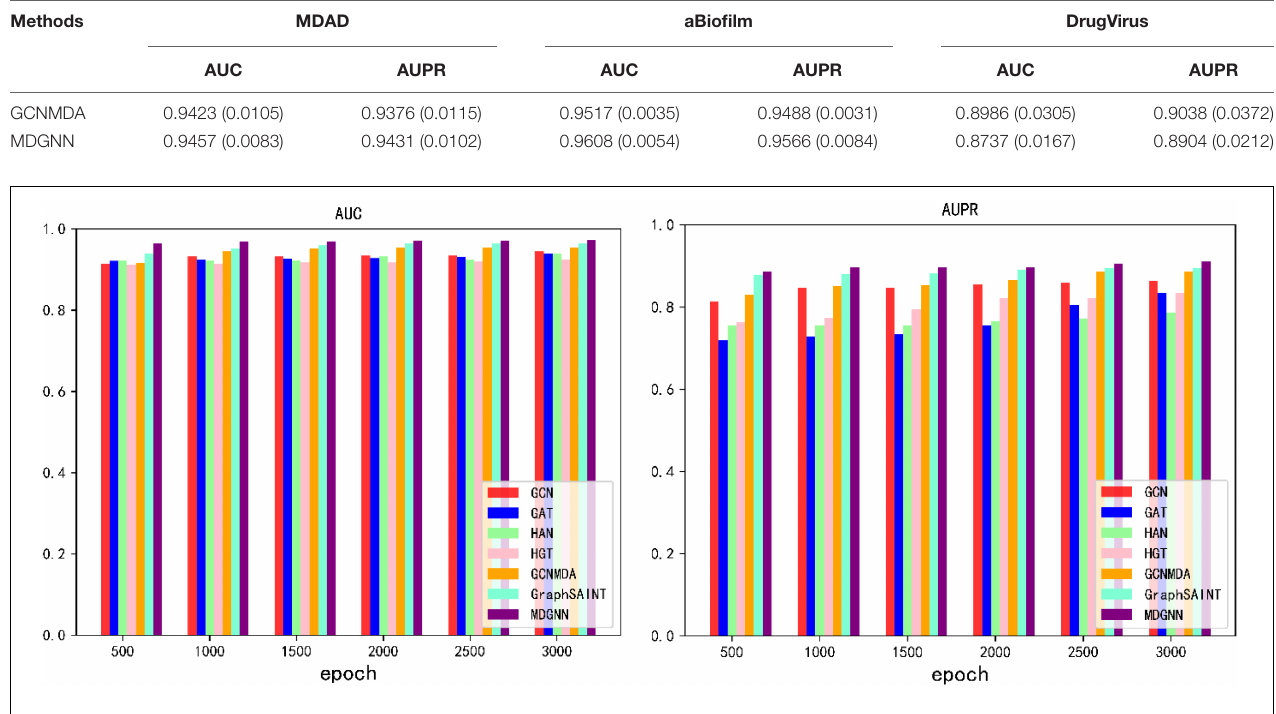
FIGURE 4 | AUC, AUPR values of different numbers of epochs.